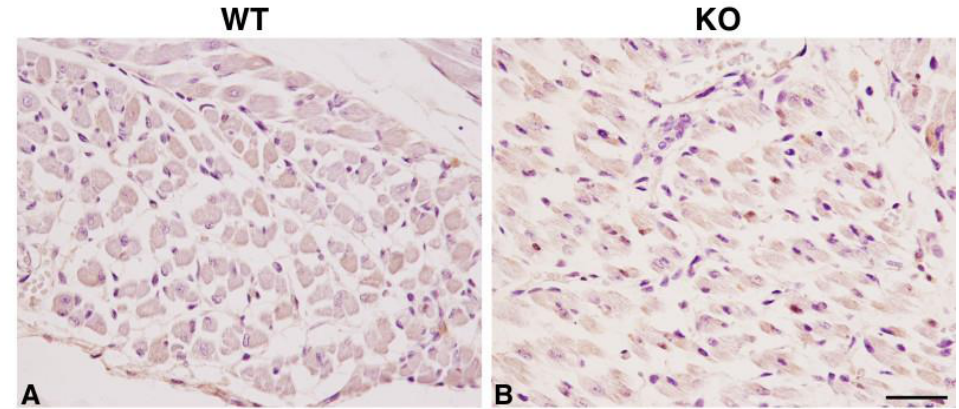
Figure 5. Analysis of skeletal muscle development in Hipk2 -KO mice embryos.